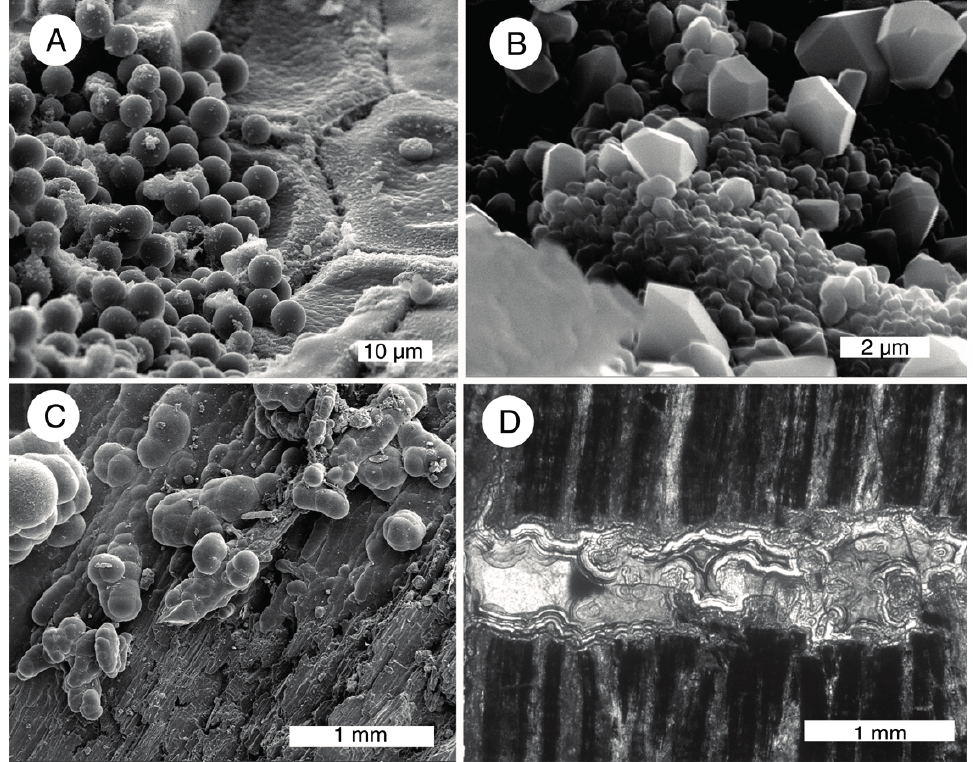
Figure 17. Silicified wood containing multiple primary silica phases. ( A ) Opal-A lepispheres precipitated on solidly-mineralized cells, transverse view, locality 2 (Cessily-Anne opal mine); ( B ) Euhedral quartz crystals formed on wood mineralized with opal-CT, locality 17; ( C ) Large-diameter botryoidal opal-CT coating wood permineralized with fine-grained opal-CT, locality 6; ( D ) Opal-CT wood, with transverse fracture filled with multi-layered chalcedony, locality